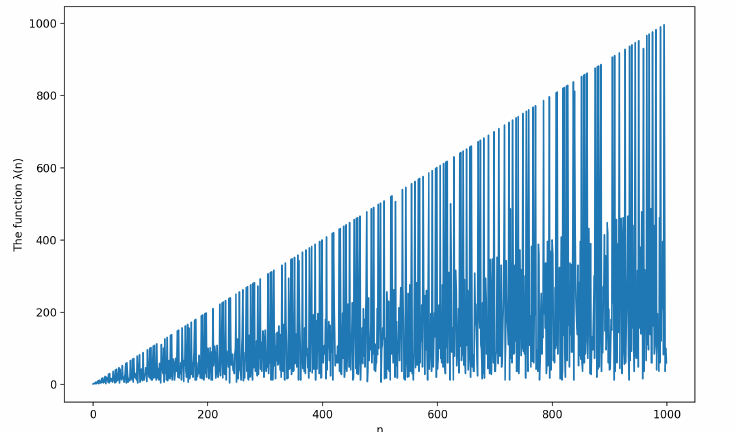
Figure 1. The first 1000 values of the Carmichael function.